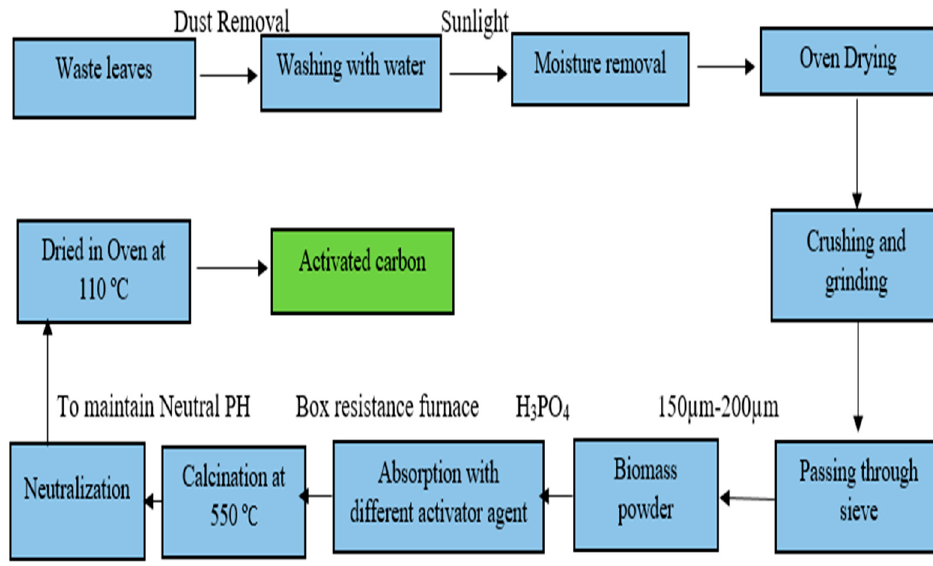
Figure 1. Preparation steps of AC from “Lantana camara and Olive trees” by chemical activation.